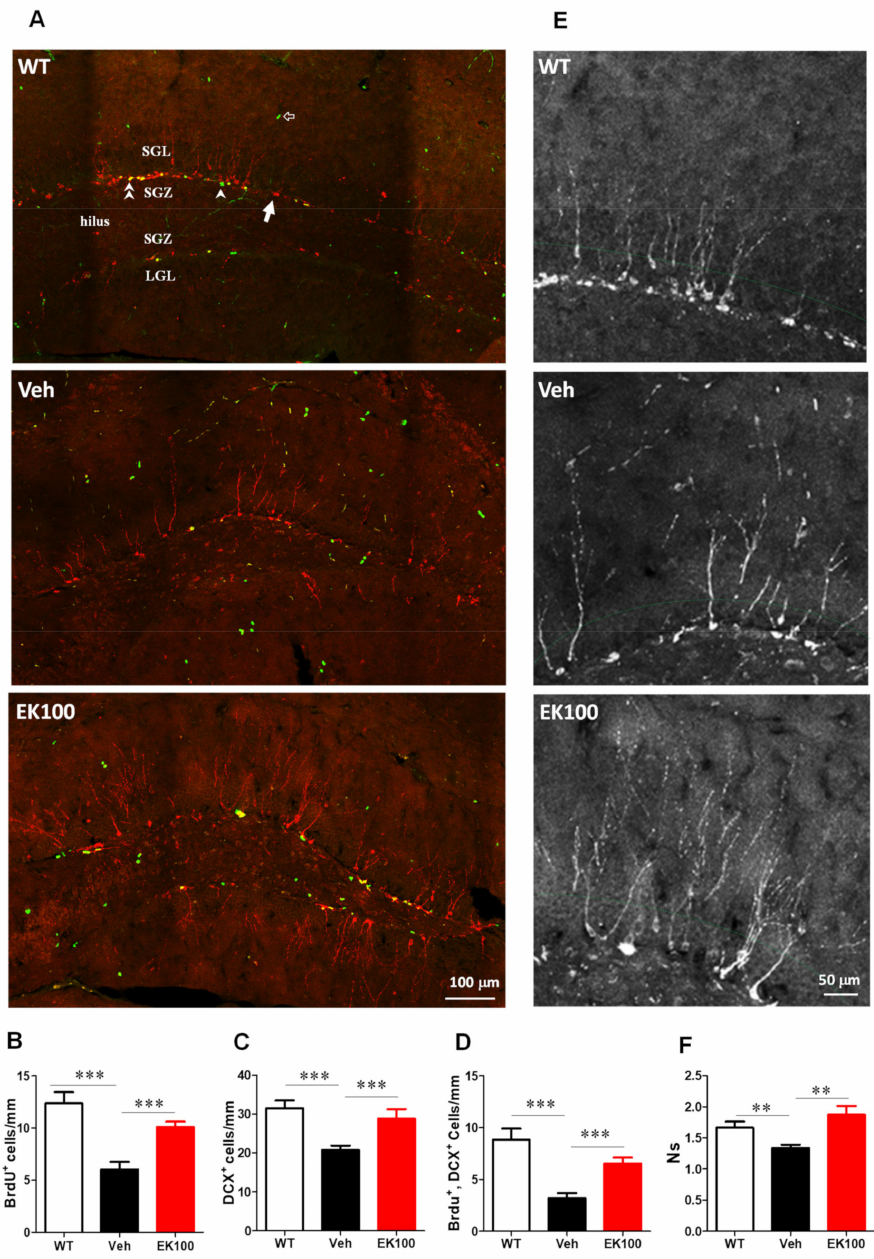
Figure 7. EK100 promotes hippocampal neurogenesis in APP/PS1 mice. APP/PS1 transgenic mice orally administered with vehicle (Veh) or EK100 (30 mg · kg − 1 · day − 1 , n = 6 each) for 1 month. Wild-type (WT) mice were used as non-transgenic control. Hippocampal neurogenesis was detected by immunohistochemical staining with doublecortin antibody (DCX, red) and BrdU antibody (green). The representative images of the dentate gyrus are shown in ( A ). Arrow indicated DCX-labeled newly born neuron; arrow head indicates proliferating type 2 neuroprogenitor; double arrow head indicates the newly born neuron immediately after proliferation; hollow arrow indicates proliferating cells other than the neuroprogenitor. ML, molecular layer; UGL, upper blade granular cell layer; SGZ, subgranular zone; LGL, lower blade granular cell layer. Scale bar: 100 µ m. Panels B – D show the number/mm SGZ of BrdU positive cells (BrdU + , B ); DCX-positive cell (DCX + , C ) and the cells with double labeling (BrdU + , DCX + , D ). ( E ) The representative immunostaining images of the upper blade dentate gyrus area are shown. Scale bar: 50 µ m. Secondary dendrites of the DCX + cells are counted along the middle of granular cell layer (GCL, green dashed line). ( F ) The dendritic complexity was analyzed by laminar quantification. The branch ratio of secondary dendrites of DCX + cells were shown. Dendrites of DCX + cells are counted along the middle of the GCL. The results are the mean ± S.E.M. Significant differences between the Veh group and the other groups. **, p < 0.01; ***, p <